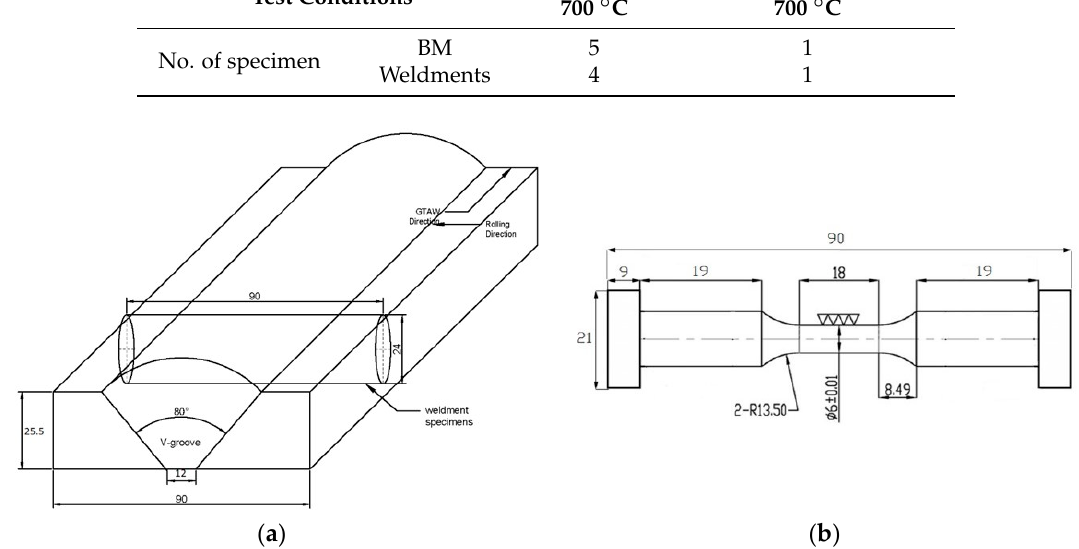
Figure 1. ( a ) Configuration of the weldments plate; ( b ) shape and dimension (unit: mm) of cylindrical low ‐ cycle fatigue (LCF) specimen. low-cycle fatigue (LCF)